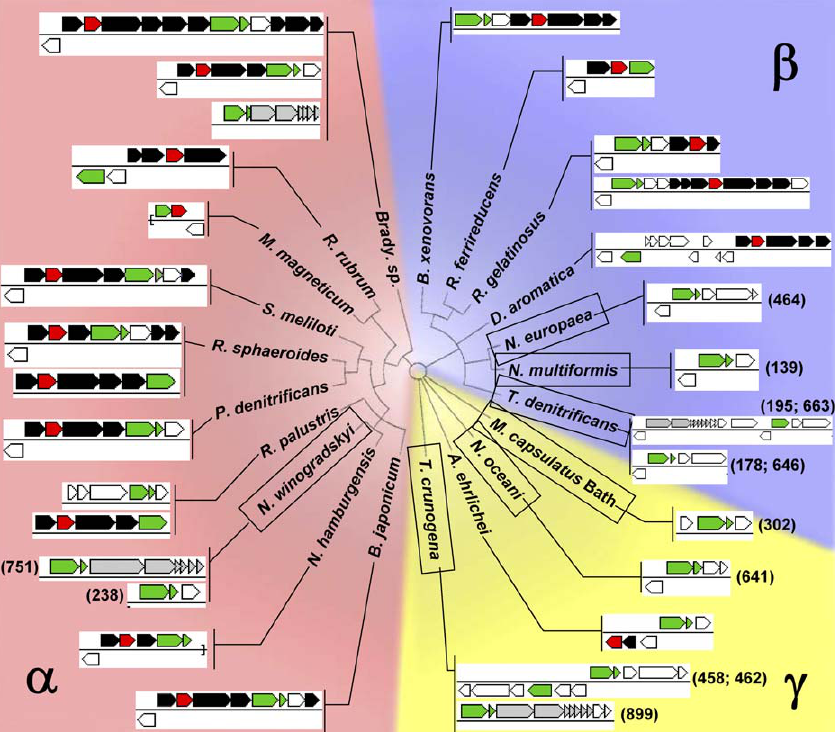
Figure 6. Calvin-Benson-Bassham Cycle Gene Organization in Proteobacteria RubisCO genes (cbbLS and cbbM) are green, phosphoribulokinase genes (cbbP) are red, other genes encoding Calvin-Benson-Bassham cycle enzymes are black, and carboxysome structural genes are grey. For species in which cbbP is not near cbbLS or cbbM, the distance from the RubisCO gene to cbbP in kbp is indicated in parentheses. Thiob. denitrificans has two cbbP genes, so two distances are indicated for this species. Names of organisms that are unable to grow well as organoheterotrophs are boxed. Abbreviations and accession numbers for the 16S sequences used to construct the cladogram are as follows: A. ehrlichei, Alkalilimnicola ehrlichei, AF406554; Brady. sp., Bradyrhizobium sp., AF338169; B. japonicum, Bradyrhizobium japonicum, D13430; B. xenovorans, Burkholderia xenovorans , U86373; D. aromatica, Dechloromonas aromatica, AY032610; M. magneticum, Magnetospirillum magneticum, D17514; M. capsulatus, Methylococcus capsulatus BATH, AF331869; N. hamburgensis, Nitrobacter hamburgensis, L11663; N. winogradskyi, Nitrobacter winogradskyi, L11661; N. oceani, Nitrosococcus oceani, AF363287; N. europaea, Nitrosomonas europaea, BX321856; N. multiformis, Nitrosospira multiformis, L35509; P. denitrificans, Paracoccus denitrificans, X69159; R. sphaeroides, Rhodobacter sphaeroides, CP000144; R. ferrireducens, Rhodoferax ferrireducens, AF435948; R. palustris, Rhodopseudomonas palustris, NC 005296; R. rubrum, Rhodospirillum rubrum, D30778; R. gelatinosus, Rubrivivax gelatinosus, M60682; S. meliloti, Sinorhizobium meliloti, D14509; T. denitrificans, Thiobacillus denitrificans, AJ43144; T. crunogena, Thiomicrospira crunogena, AF064545. The cladogram was based on an alignment of 1,622 bp of the 16S rRNA genes, and is the most parsimonious tree (length 2,735) resulting from a heuristic search with 100 replicate random step-wise addition and TBR branch swapping (PAUP*4.0b10 [113]). Sequences were aligned using ClustalW [114], as implemented in BioEdit. Percent similarities and identities for cbbL, cbbM, and cbbP gene products, as well as gene locus tags, are provided